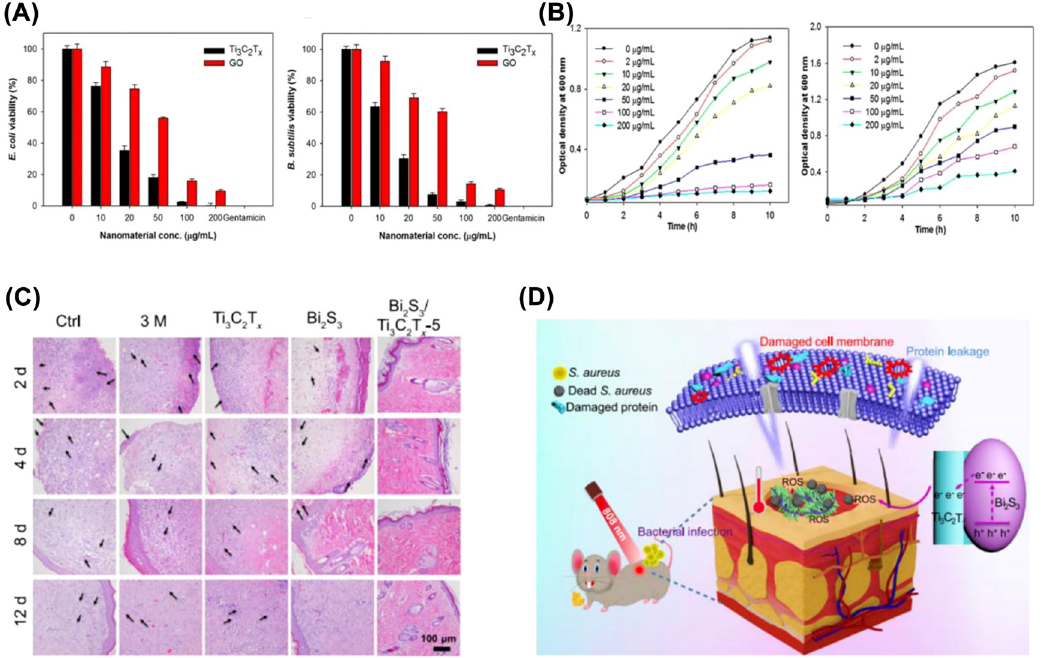
C T and GO in 3 2 x S /Ti C T Schottky action 2 3 3 2 x